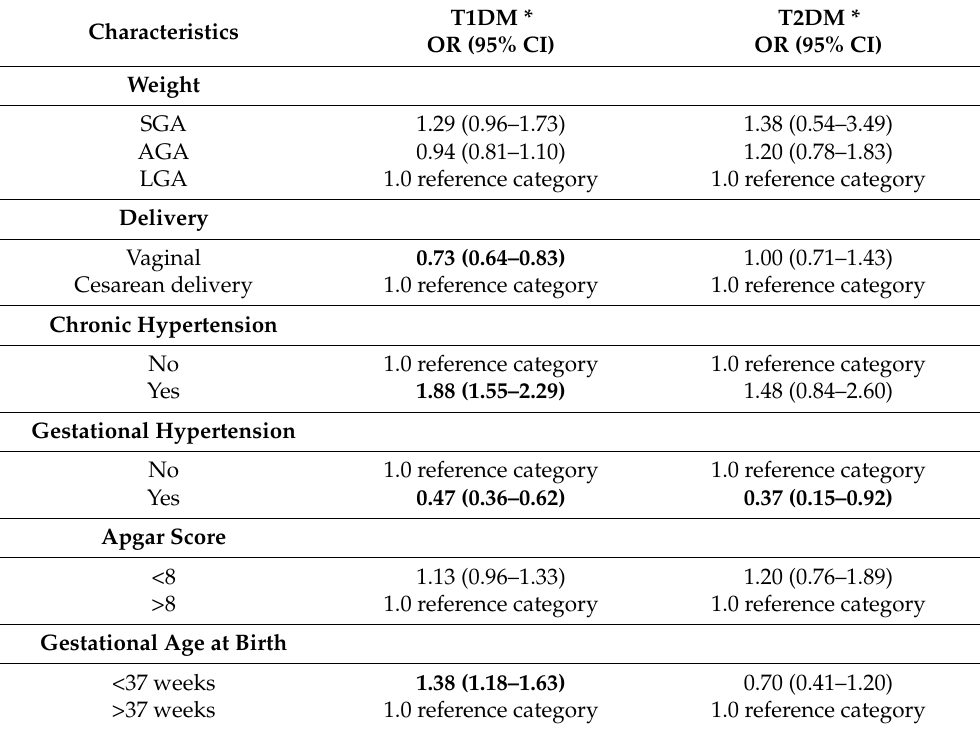
Table 2. Multivariate logistic regression analysis with the type of diabetes as an outcome variable and GDM as a reference